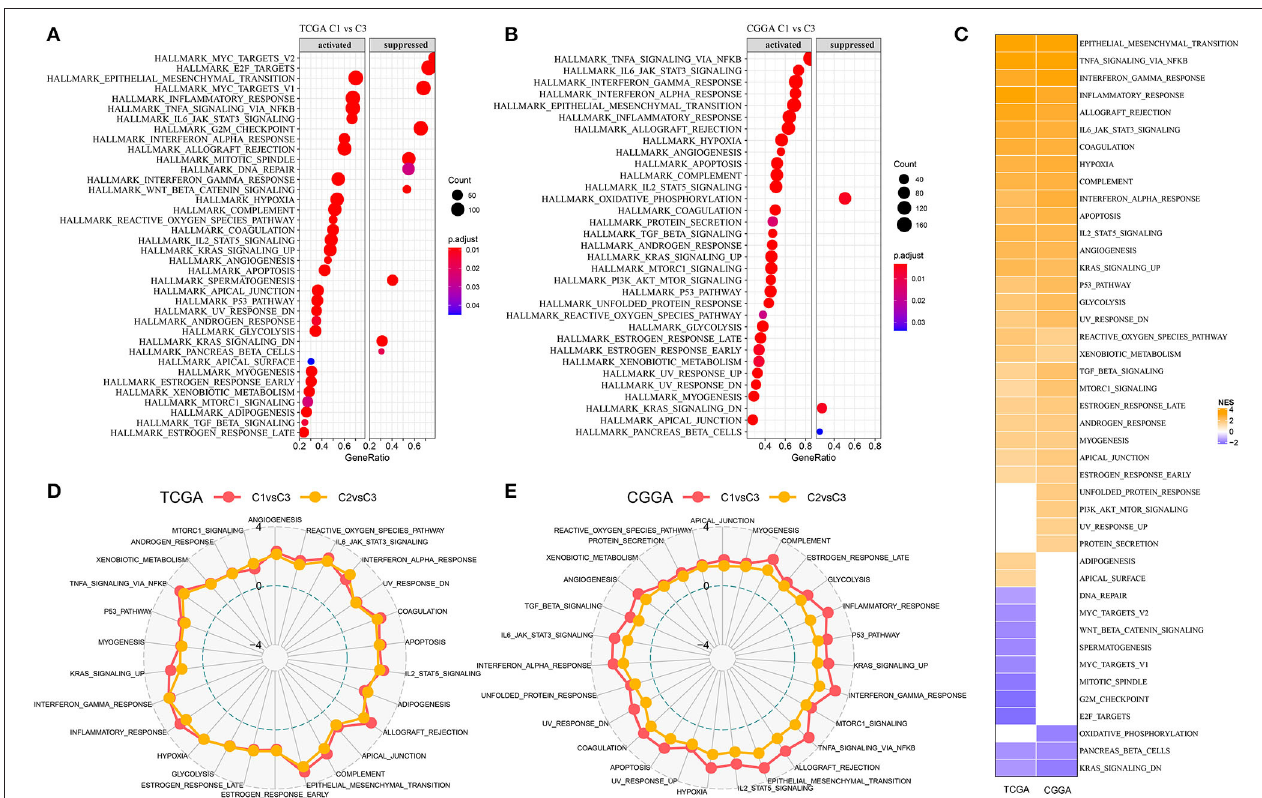
FIGURE 3 | Differentially enriched pathways among three subtypes. (A,B) Relatively activated and suppressed hallmark pathways of C1 subtype comparing with C3 subtype in TCGA-GBM and CGGA-GBM datasets. Count represents the number of genes. (C) Normalized enriched score (NES) of differentially enriched pathways in two datasets. (D,E) Rader plots of upregulated pathways of C1 vs. C3 and C2 vs. C3 in two datasets. Dotted circles from inner to outside indicate NES of − 4, 0, and 4,